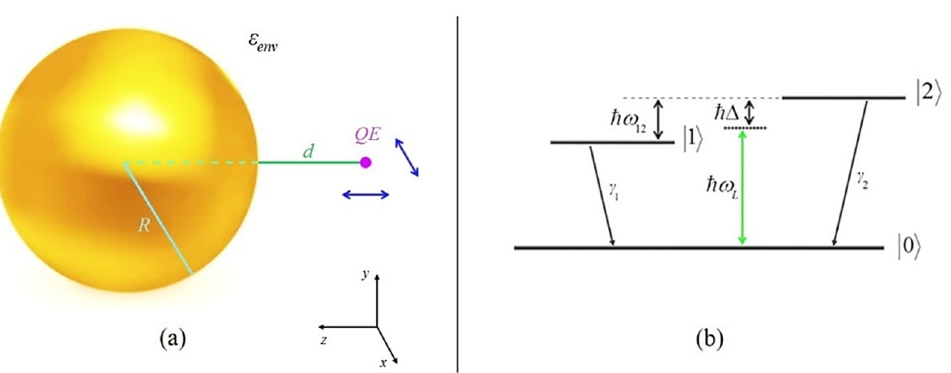
Figure 1. Caption ( a ): Graphic representation of the hybrid nanostructure: a gold nanosphere of radius R = 80 nm is coupled to a QE which is placed at a distance d away from its surface. The system is embedded in a background material with dielectric constant ε env = 2.25. The alternative orientations of the QE transition dipole moment are indicated with the blue arrows. Caption ( b ): V-type energy-level scheme of the QE driven by a laser field with angular frequency ω L . The energy level spacing between the upper levels | 1 (cid:105) and | 2 (cid:105) , the detuning of the field from resonance and the spontaneous emission rates are denoted by (cid:125) ω 21 , ∆ and γ i ( i = 1, 2 ) , tively.